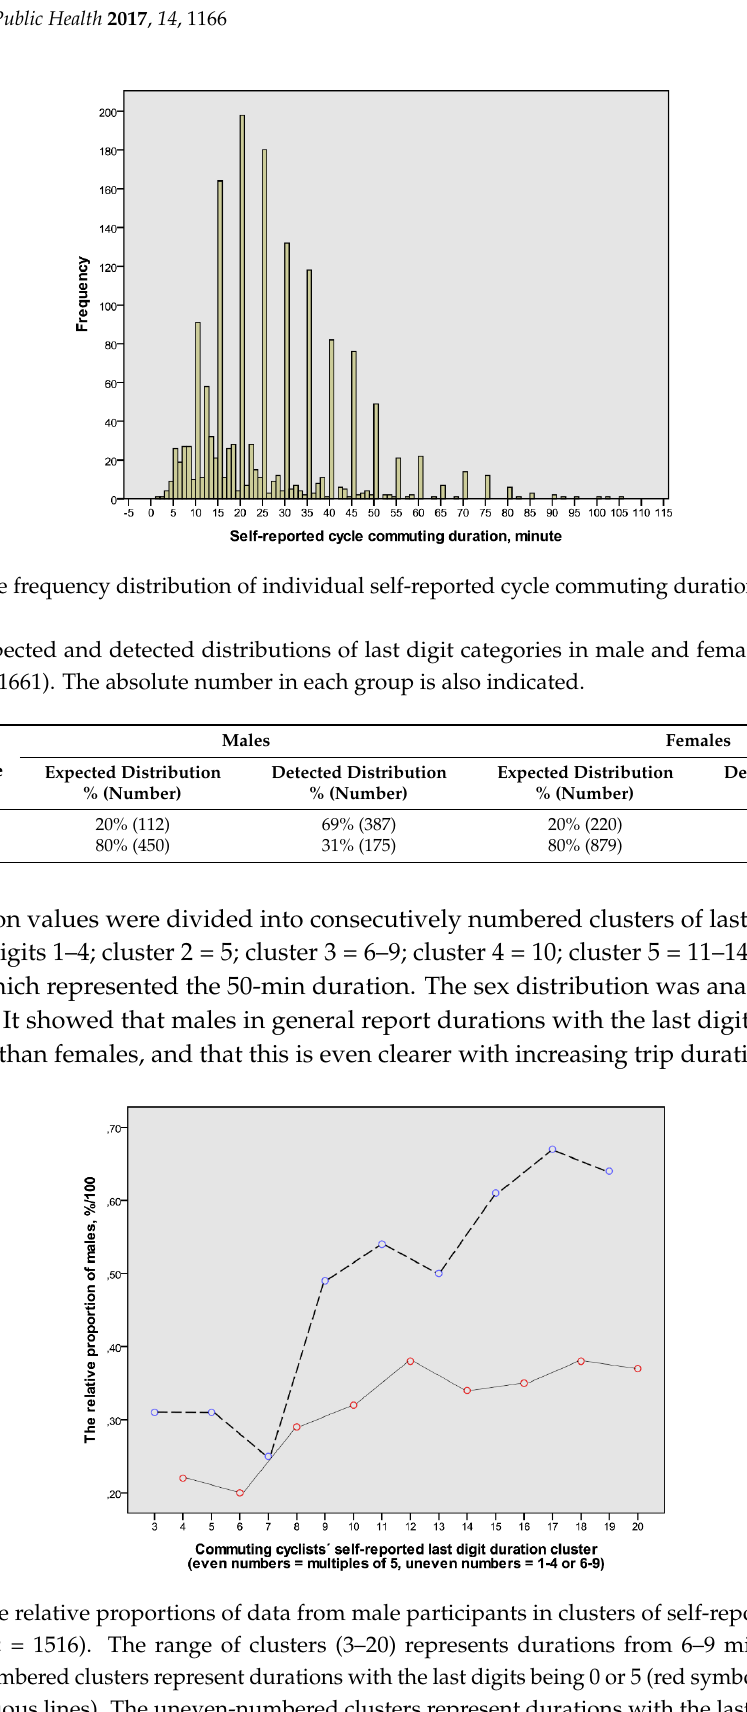
Figure 4. The relative proportions of data from male participants in clusters of self-reported cycling durations ( n = 1516). The range of clusters (3–20) represents durations from 6–9 min to 50 min. The even-numbered clusters represent durations with the last digits being 0 or 5 (red symbols connected with continuous lines). The uneven-numbered clusters represent durations with the last digits being 1–4 or 6–9 (blue symbols connected with dashed lines). Cluster 4 = 10 min; 8 = 20 min; 12 = 30 min; 16 = 40 min; and 20 = 50 min. For further explanations, see Methods.